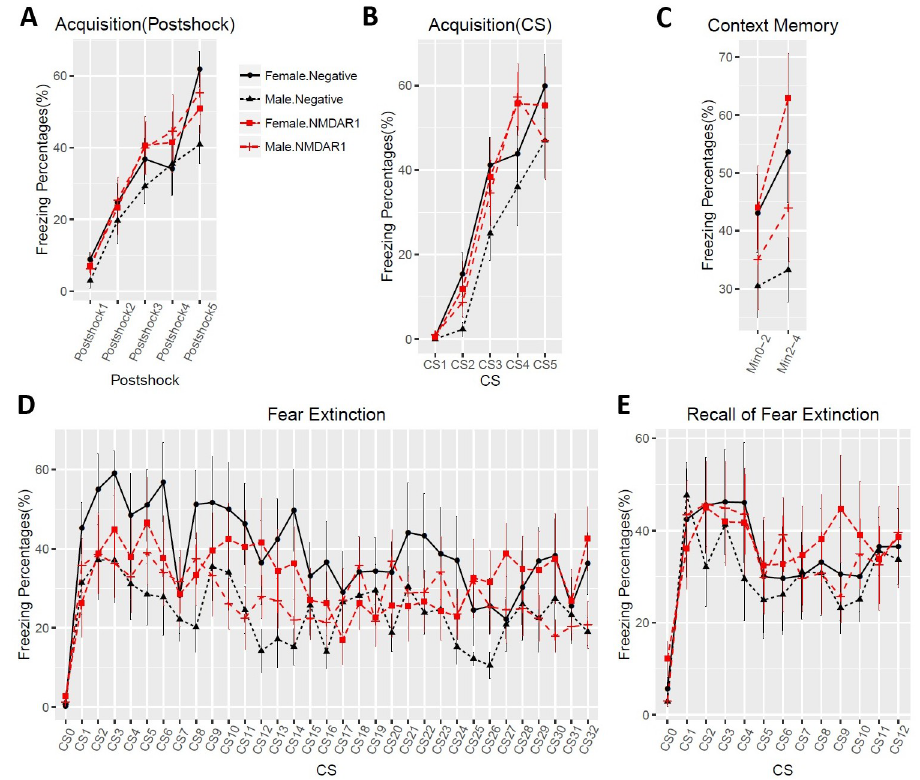
Fig 7. No effects of the anti-NMDAR1 autoantibodies on fear conditioning. (A) In Day1 fear acquisition, there is neither sex (F(1,31) = 0.35, p = 0.56) nor autoantibody (F(1,31) = 0.51, p = 0.48) effect on post-shock freezing time. (B) Neither sex (F(1,31) = 1.93, p = 0.17) nor autoantibody (F(1,31) = 0.61, p = 0.44) effect was observed during CS tone. (C) In Day2 context memory, female mice have significant higher freezing percentages (F(1,35) = 5.2, p = 0.029) than the male mice, but there is no autoantibody effect (F(1,35) = 0.9, p = 0.35). (D) In Day3 fear extinction, there is a trend of sex effect (F(1,35) = 2.94, p = 0.095), but without autoantibody effect (F(1,35) = 0.04, p = 0.85). CS0: pre-tone. (E) In Day4 recall of fear extinction, neither sex (F(1,35) = 0.24, p = 0.63) nor autoantibody (F(1,35) = 0.24, p = 0.63) effect was observed. CS0: pre-tone. All data are present as Mean+SEM.